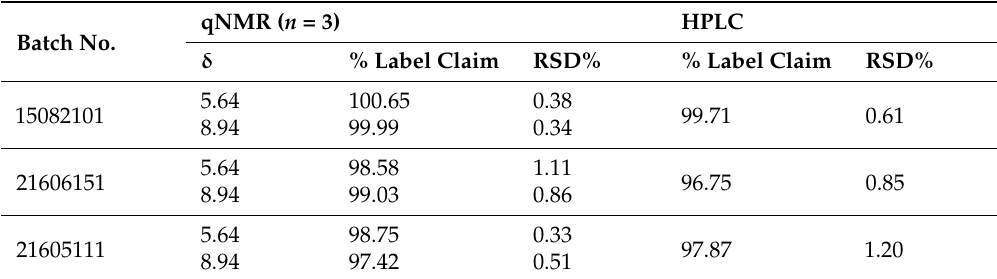
Table 5. The determination results of Orlistat by qNMR and